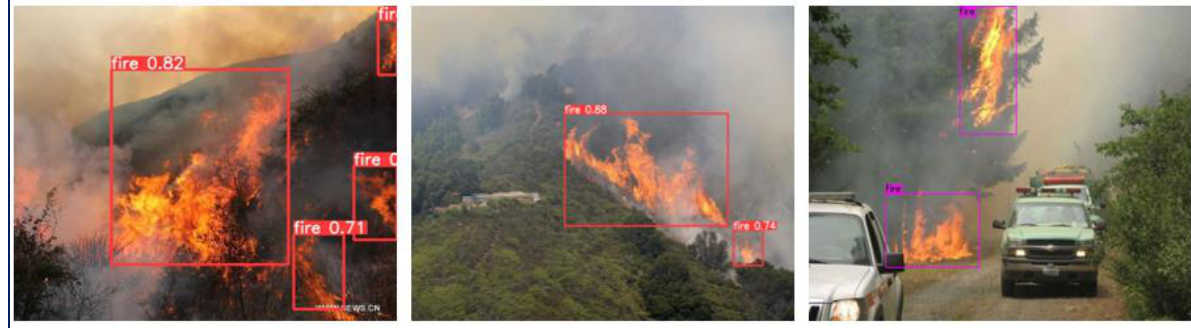
Figure 4. Visible experiment results in forest fire scenes.